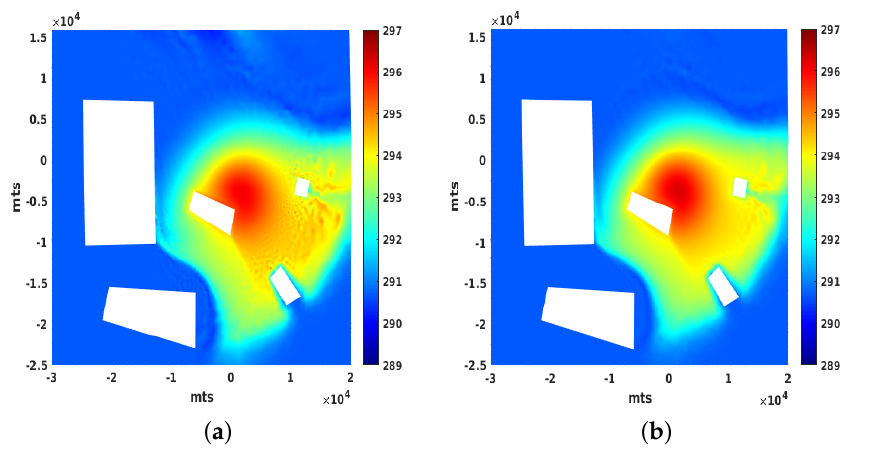
Figure 6. It was clear that the streamline diffusion stabilizer minimized the spurious oscillation without notable changes in the temperatures. ( a ) Un-stabilized solution ( ζ = 0). ( b ) Stabilized solution ( ζ = 25).